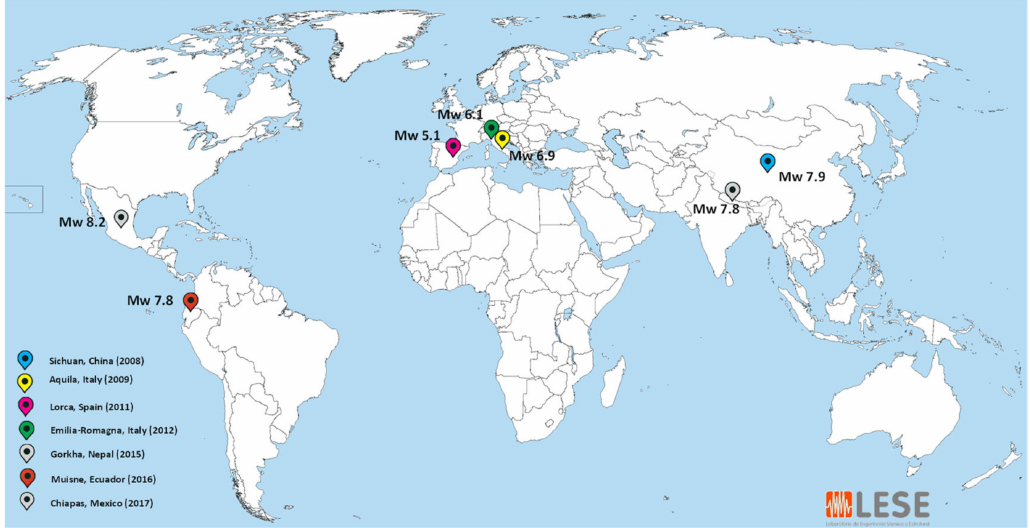
Figure 1. Location of the post-earthquake damage reconnaissance missions carried